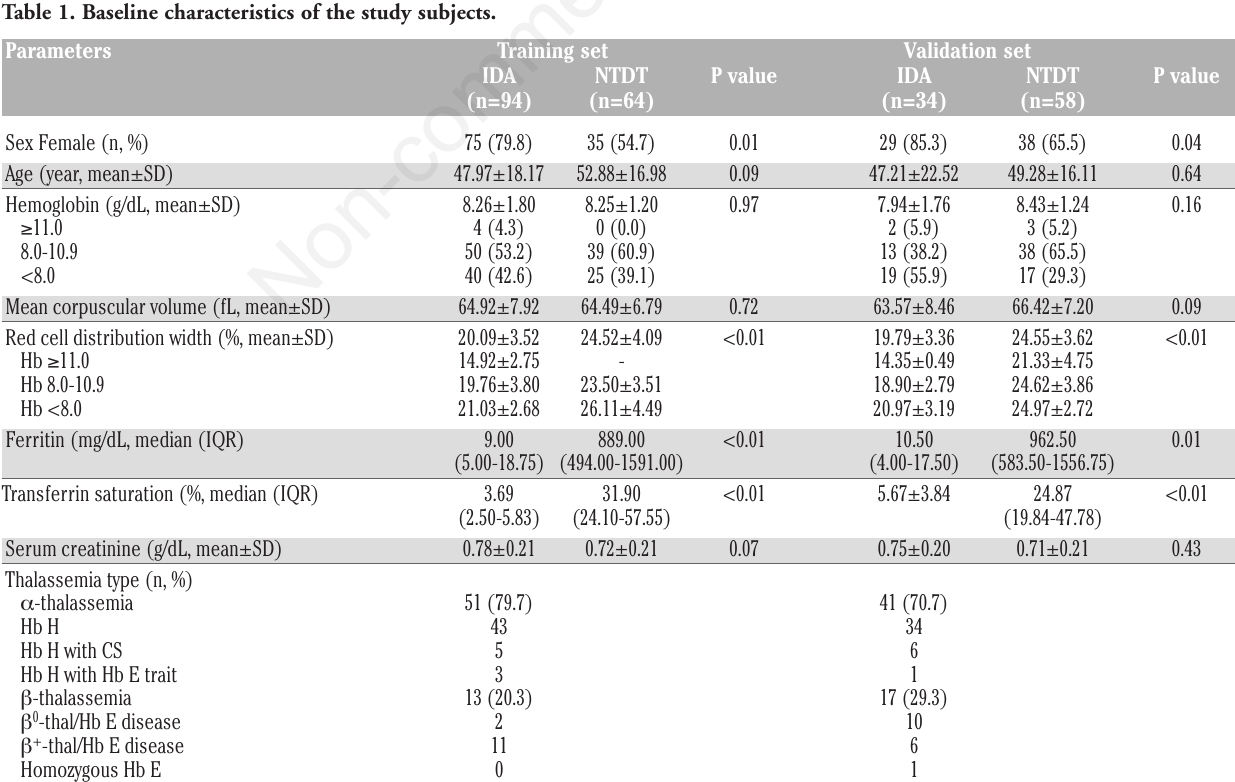
Table 1. Baseline characteristics of the study